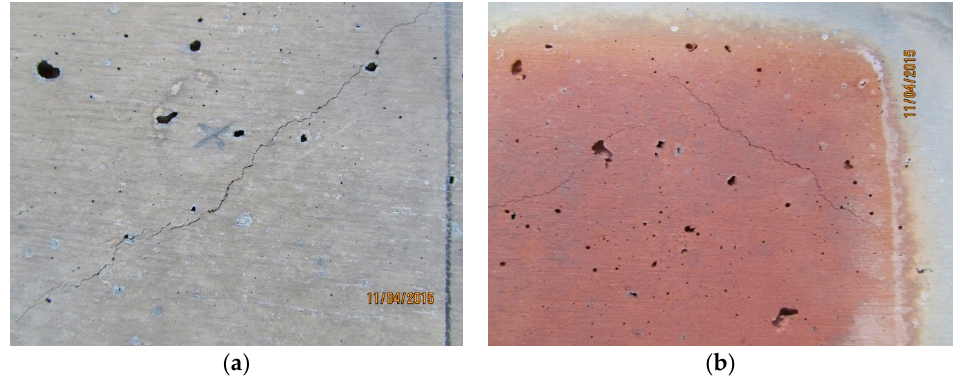
Figure 12. HTC 6A cold side: ( a ) after fire test and hot side; ( b ) after fire test showing fine cracks.